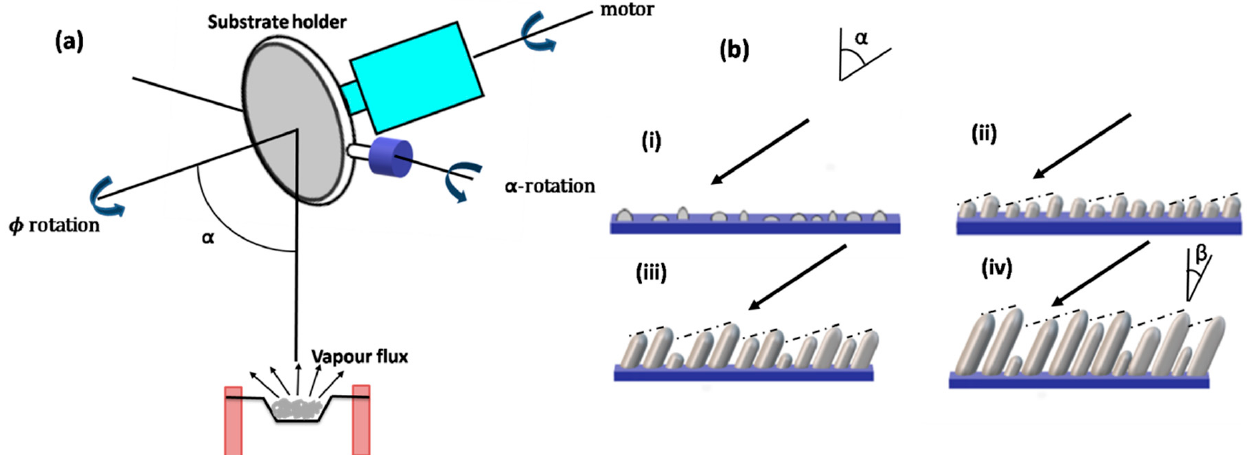
Figure 1. ( a ) Schematic of GLAD setup where α is the angle subtended by the incident vapor flux with respect to substrate normal and ɸ is the azimuthal angle. ( b ) Mechanistic view of GLAD-based growth. (i) Incident vapor flux, shown by full arrows at an angle ( α ), resulting in random nucleation. (ii) Nucleus growth casting a nearby shadow, as shown by dotted lines. (iii) Column growth in progress, suppressing neighbors’ growth via shadowing. (iv) Full column growth at a certain specific angle ( β ) with respect to the normal.